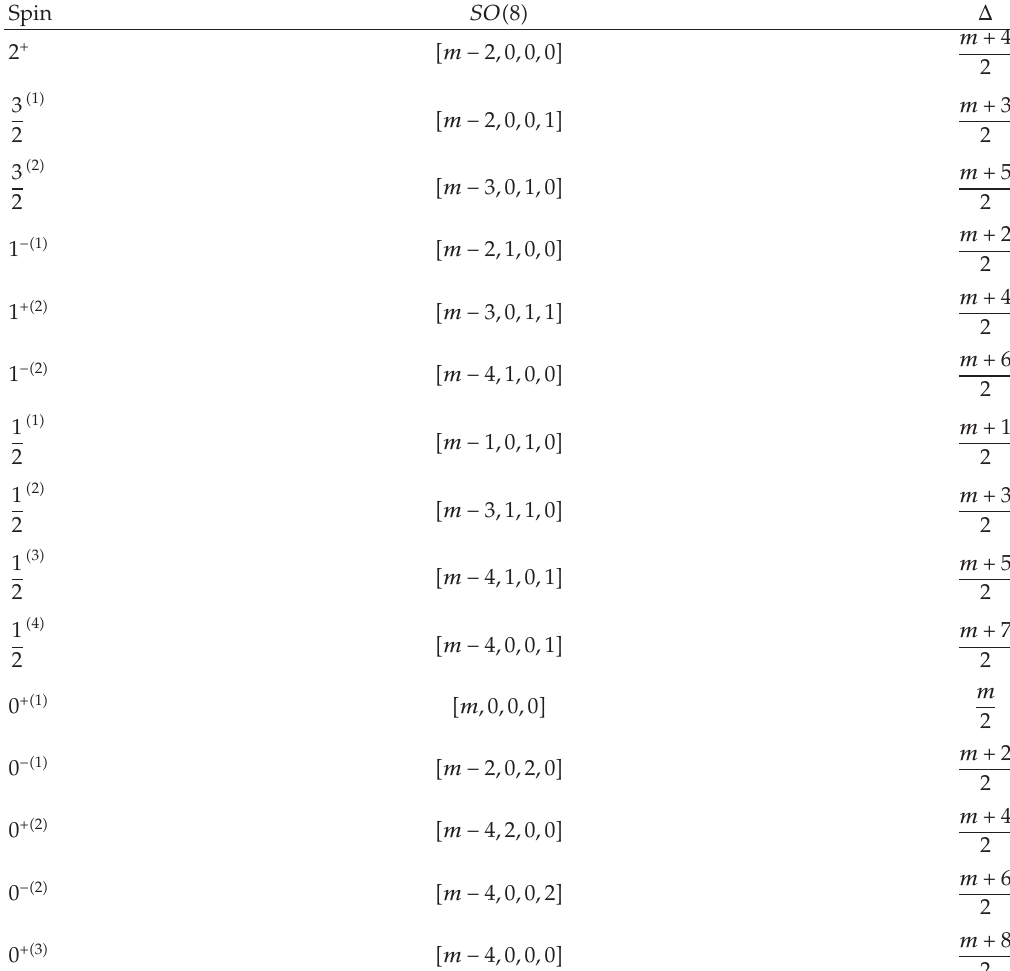
Table 2: The spectrum on S 7